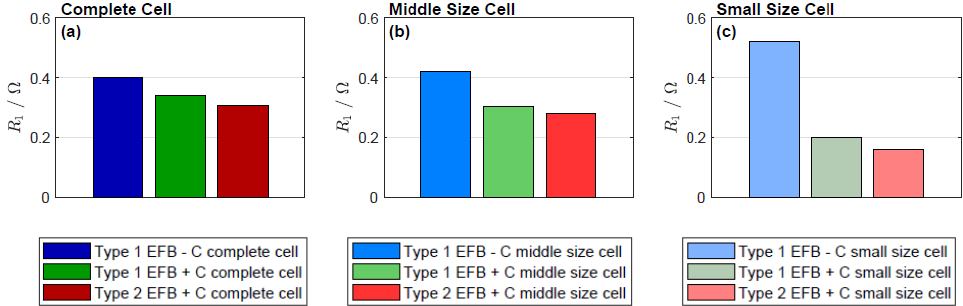
Figure 9. Fitting result R 1 of the laboratory test cells for ( a ) complete cell: 8P8N/8P9N, ( b ) middle size cell: 3P2N and ( c ) small size cell: 2P1N.